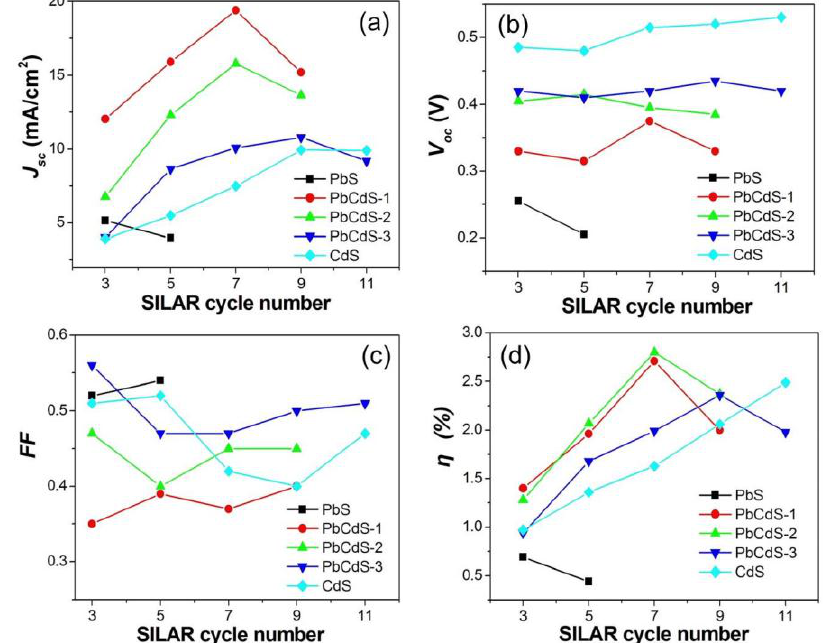
Figure 5. The photovoltaic parameters of QDSCs employing CdS, PbS, and three Pb x Cd 1− x S QDs in terms of the number of SILAR cycles. ( a ) short-circuit current density ( J sc ); ( b ) open-circuit voltage ( V oc ); ( c ) fill factor ( FF ); ( d ) efficiency (η).